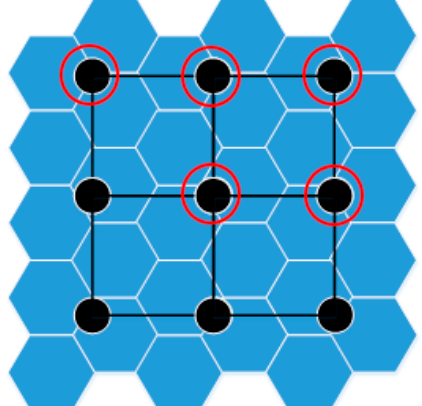
Figure 5. Simulation of irradiation of graphene by drawing. The atoms in the red circle are the covered atoms.